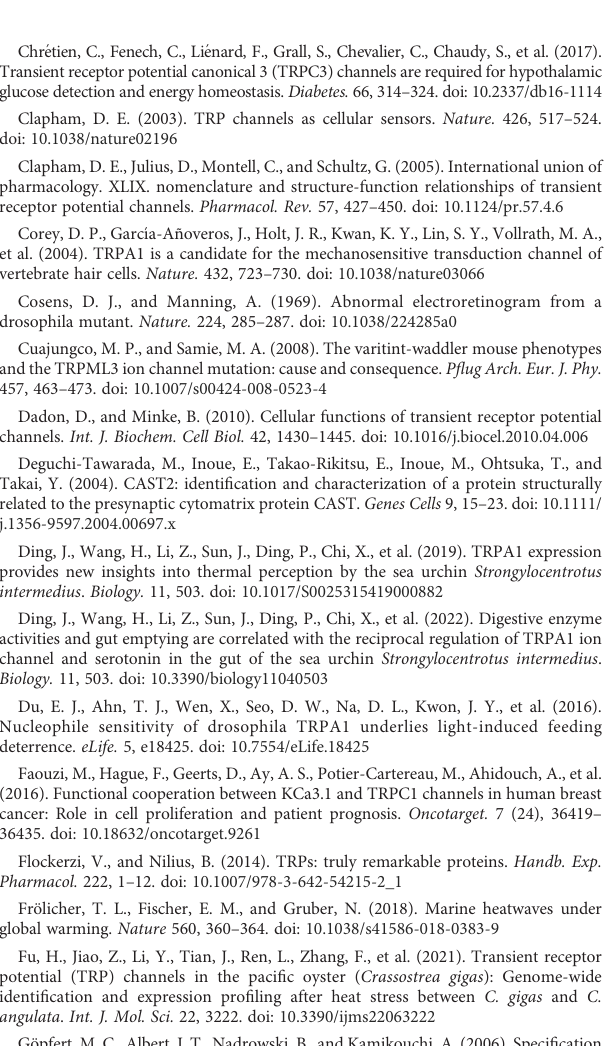
SUPPLEMENTARY FIGURE 6 Intestinal anatomy of A. japonicus in (A) control group and (B) chronic heat